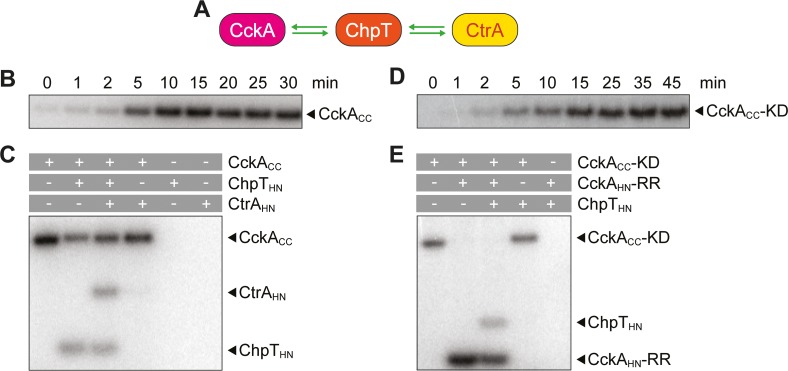
The connectivity within the CckA-ChpT-CckA phosphorelay is conserved in H. neptunium.(A) Scheme of the CckA-ChpT-CtrA phosphorelay. Green arrows indicate phosphotransfer. (B) Autophosphorylation of CckACC upon incubation with [γ32P]-ATP. Samples were taken at the indicated time points after the start of the reaction and analyzed by SDS-PAGE prior to detection of radioactivity by phosphor imaging. (C)
In vitro phosphotransfer from ChpTHN to CtrAHN with CckACC as a phosphoryl donor. After autophosphorylation of CckACC for 30 min, the indicated proteins (marked with pluses) were mixed and incubated for 5 min. After termination of the reactions by addition of SDS sample buffer, the mixtures were separated by SDS-PAGE and radioactivity was detected by phosphor imaging. (D) Autophosphorylation of CckA-KDCC upon incubation with [γ32P]-ATP. Samples were taken at the indicated time points and analyzed by SDS-PAGE prior to detection of radioactivity by phosphor imaging. (E)
In vitro phosphotransfer from CckA-RRHN to ChpTHN with CckA-KDCC as a phosphoryl donor. After autophosphorylation of CckA-KDCC for 45 min, the indicated proteins (marked with pluses) were mixed and incubated for 5 min. The reaction was terminated by addition of SDS sample buffer, and the mixtures were separated by SDS-PAGE prior to detection of radioactivity by phosphor imaging.